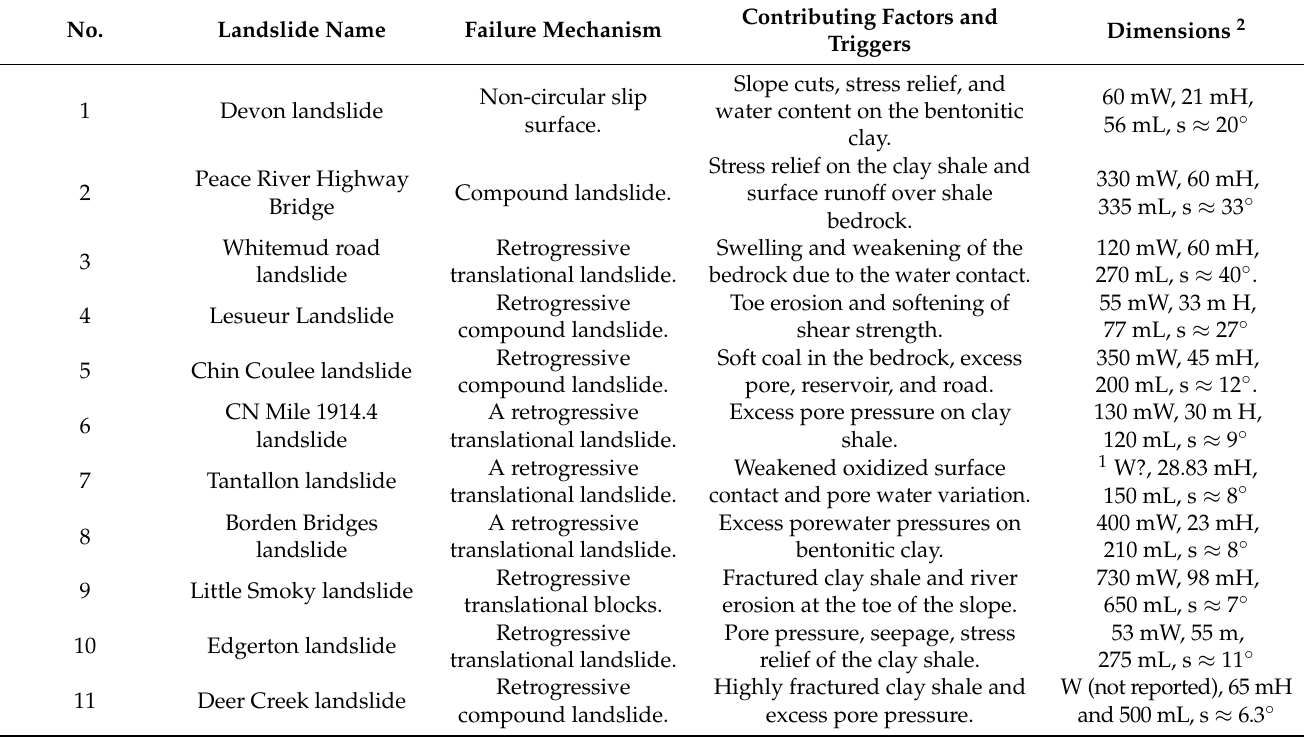
Table 1. Landslide failure mechanisms and contributing factors 1 .